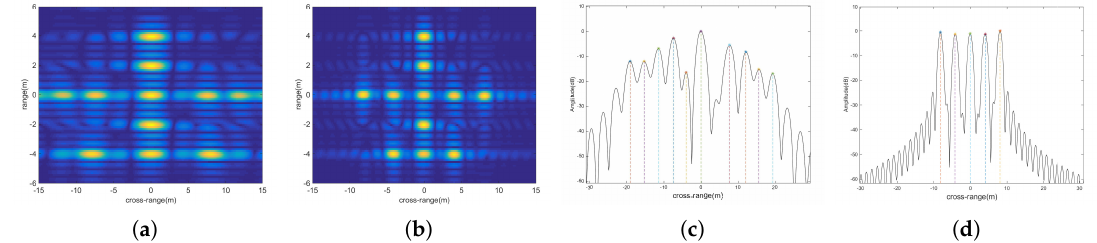
Figure 6. ( a ) Subimage by FT; ( b ) Subimage by MFT; ( c ) The profile of one range bin in ( a ); ( d ) The profile of one range bin in ( b ).